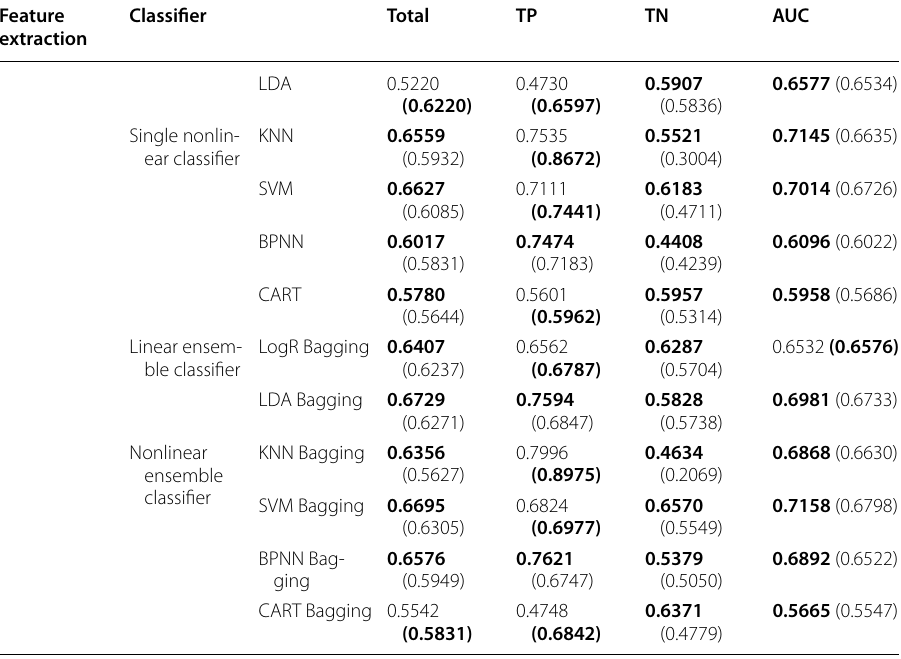
Table 6 Results of different classifiers without/with PCA in China Unionpay dataset when feature dimensions sample ≥